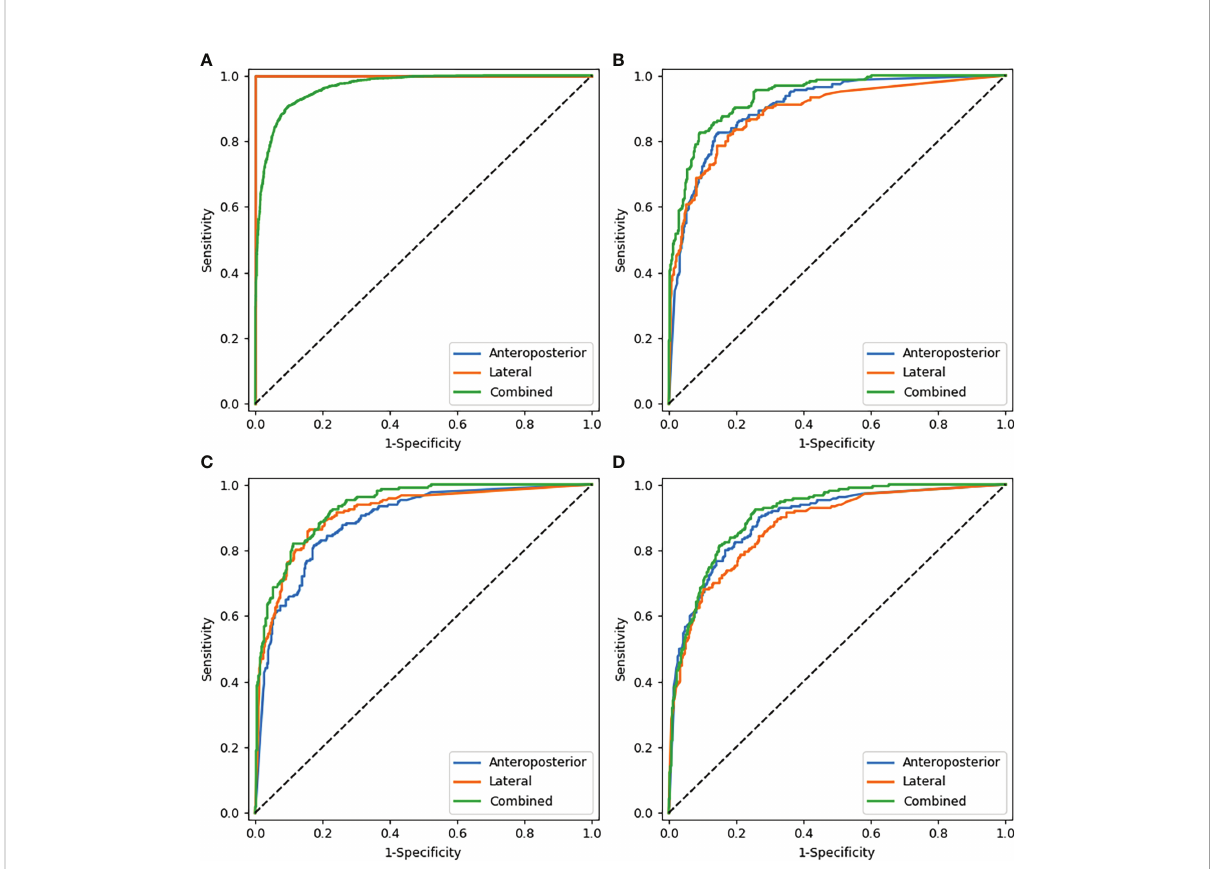
FIGURE 3 Comparison of ROC curves of the CNN models with images alone. (A – D) show the models that diagnosed osteoporosis in the training cohort, validation cohort, test cohort 1, and test cohort 2 respectively. Note: In the training cohort (A) , since AP and LAT have the same AUC values, the blue line overlaps with the orange line.